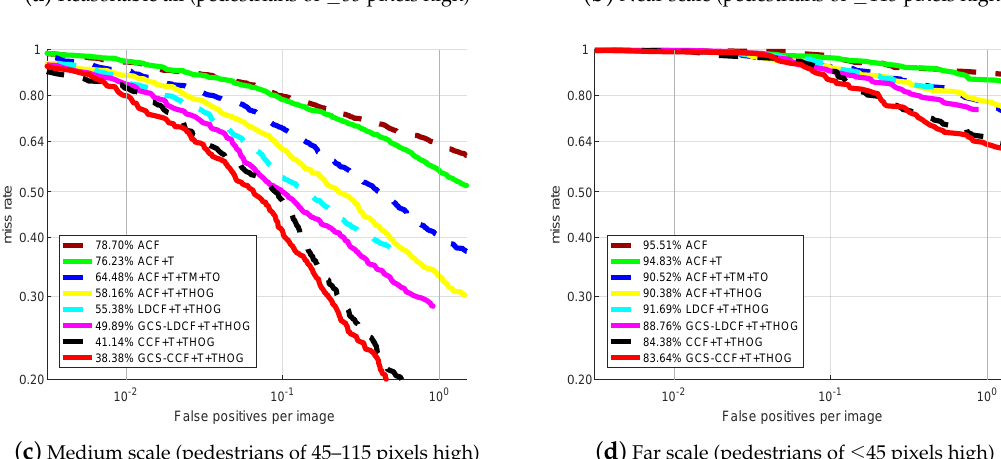
Figure 4. Comparison with popular approaches on the KAIST